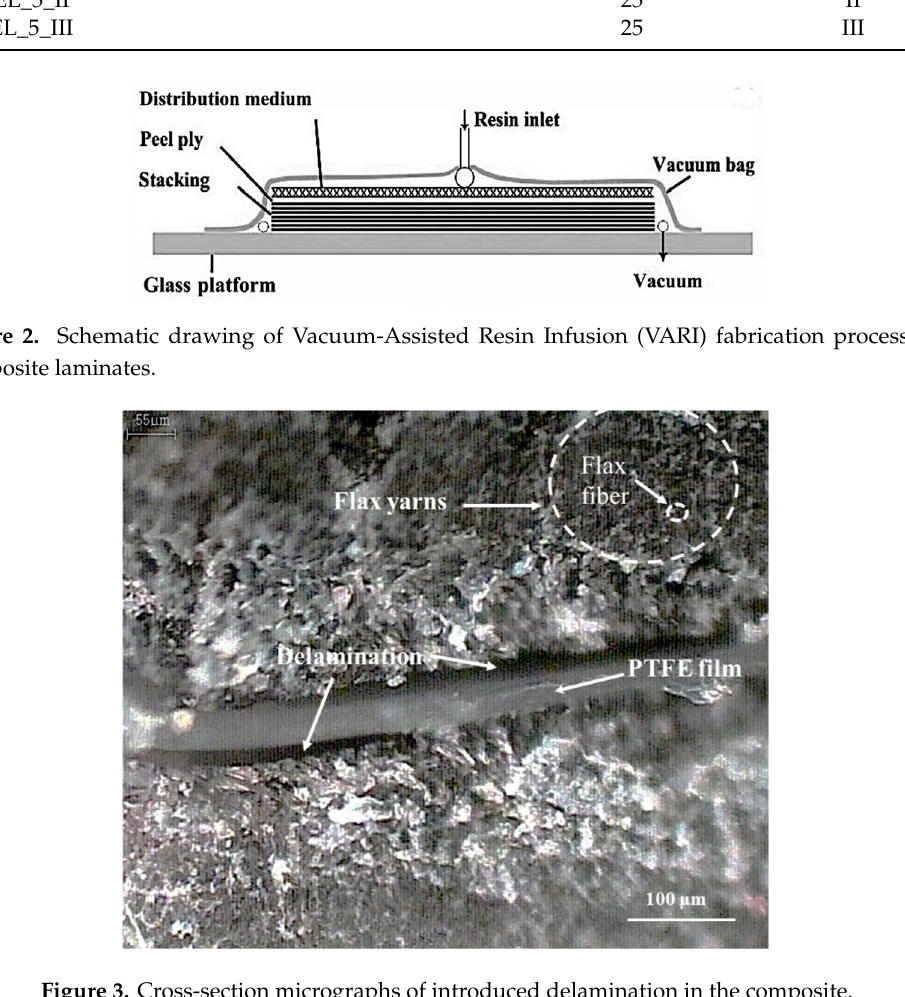
Figure 3. Cross-section micrographs of introduced delamination in the composite.